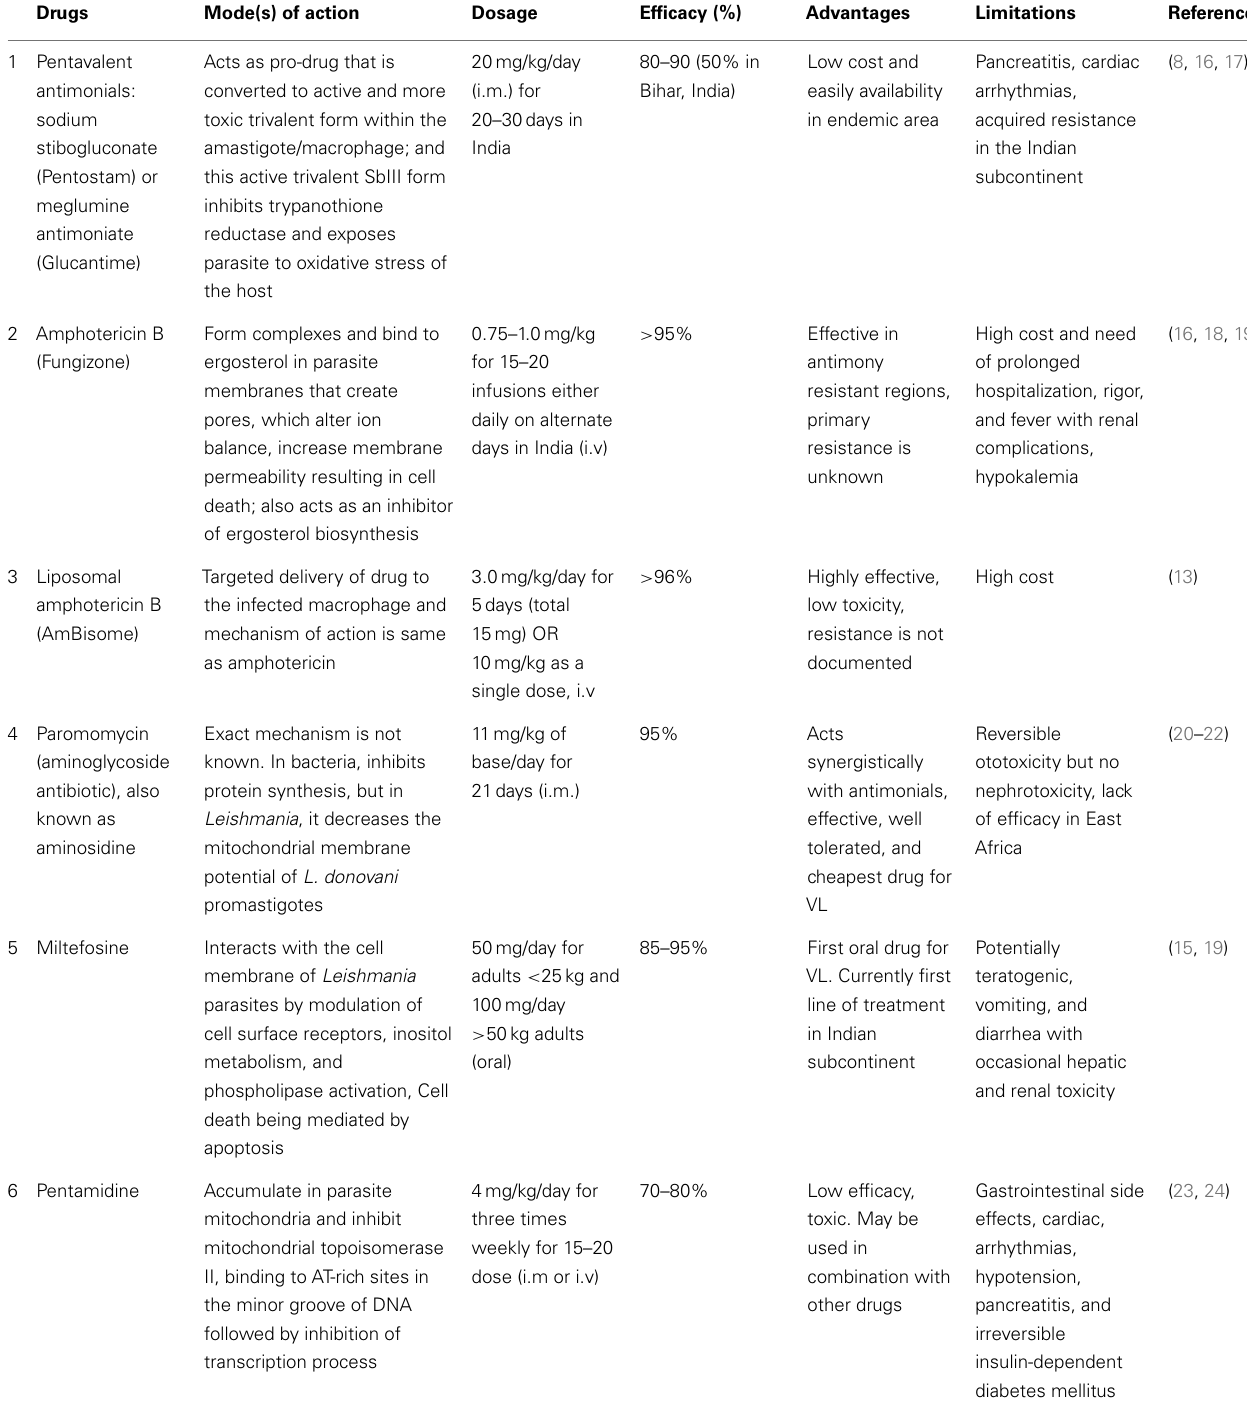
Table 1 | CurrentVL treatments with anti-leishmanial drugs: their mode(s) of action on parasites, dosage, efficacy, advantages and limitations